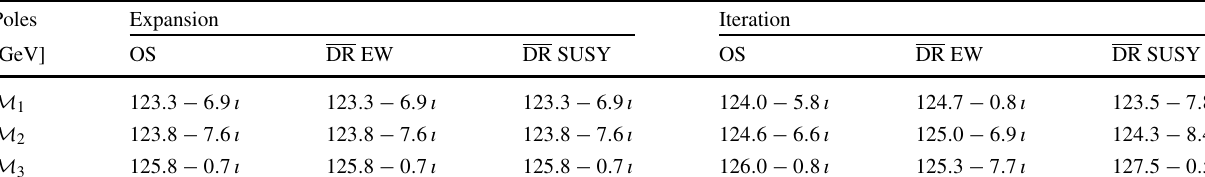
Table1 Masspolesobtainedinthescenariowiththreenear-degenerate neutral states. In the left trio of columns, the masses are derived with the expansion method. In the righter one, the iterative method is employed.